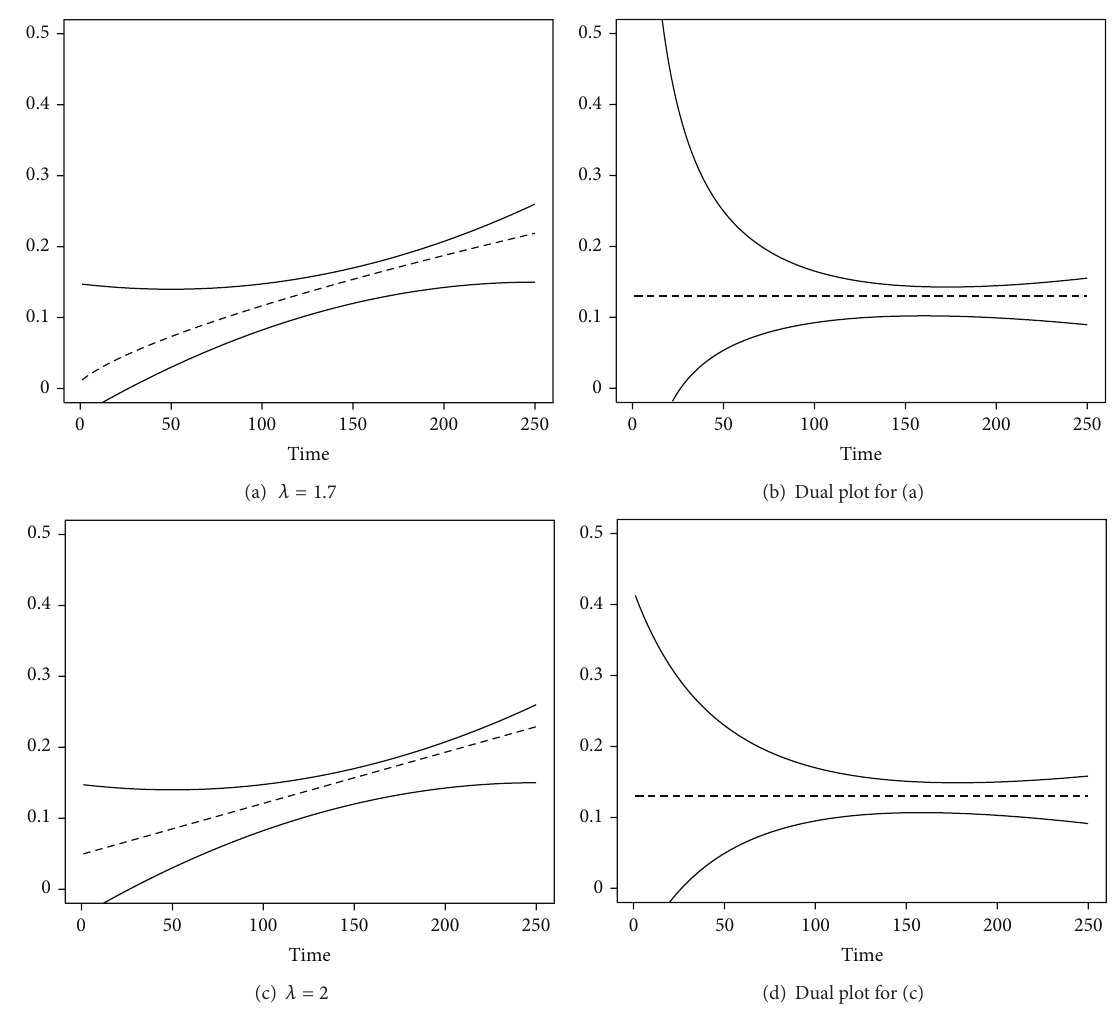
Figure 7: (a) Sketch of upper and lower Wigner-Ville curves for Example 4 showing 𝑓 𝑐 𝑔(𝑡) for 𝑓 𝑐 = 0.13 and 𝑔(𝑡) given in (6); (b) sketch of Wigner-Ville curves in dual space; (c) sketch of upper and lower Wigner-Ville curves for Example 4 showing 𝑓 𝑐 𝑔(𝑡) for 𝑓 𝑐 = 0.13 and 𝑔(𝑡) given in (7); (d) sketch of Wigner-Ville curves in dual